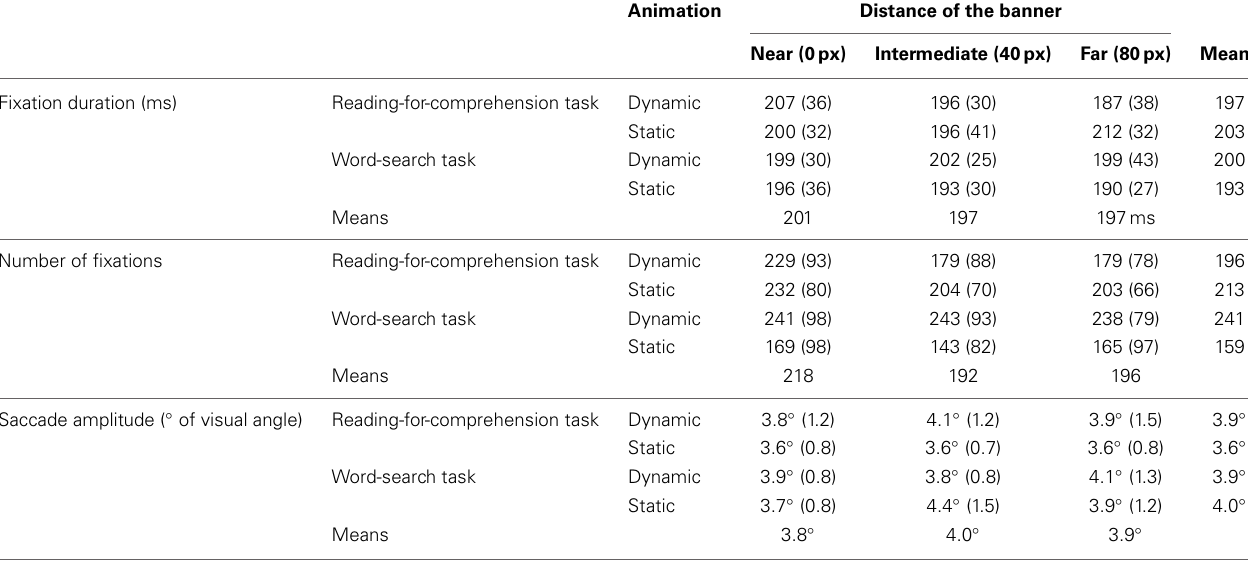
Table 2 | Average fixation durations (ms), average number of fixations and average saccade amplitude (degrees of visual angle) by task, the animation and banner location for the 13 participants who reported that they were not affected by the advertisements.